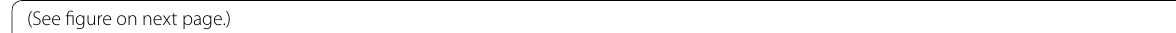
Fig. 3 Basic configurations of NIR guided-wave nanophotonic biochemical sensors. a Interferometer: (i) schematic illustration of MZI biochemical sensor; (ii) microscopic image of MZI biochemical sensor array integrated with microfluidic channel (Reproduced with permission from [30]). b Microcavity resonator: (i) schematic illustration of MRR biochemical sensor integrated with microfluidic channel (Reproduced with permission from [31]); (ii) false-color SEM image of cascaded microdisk resonators on single bus waveguide (Reproduced with permission from [40]); (iii) SEM image of microtoroid resonator (Reproduced with permission from [19]). c Photonic crystal (PhC): (i) PhC nanobeam cavity biochemical sensor